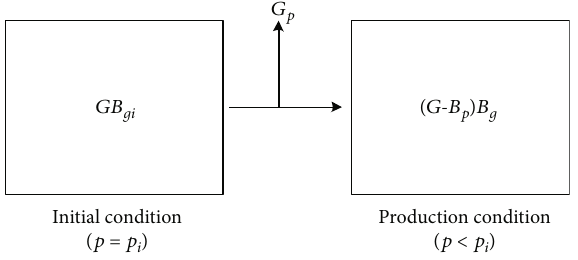
Figure 2: Tank model concept of the material balance equation [28].